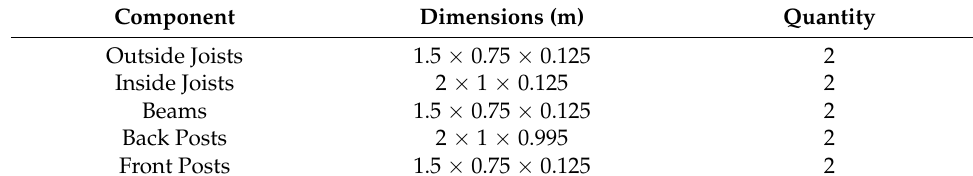
Table 2. BOM for the fixed-tilt aluminum-based PV racking system.